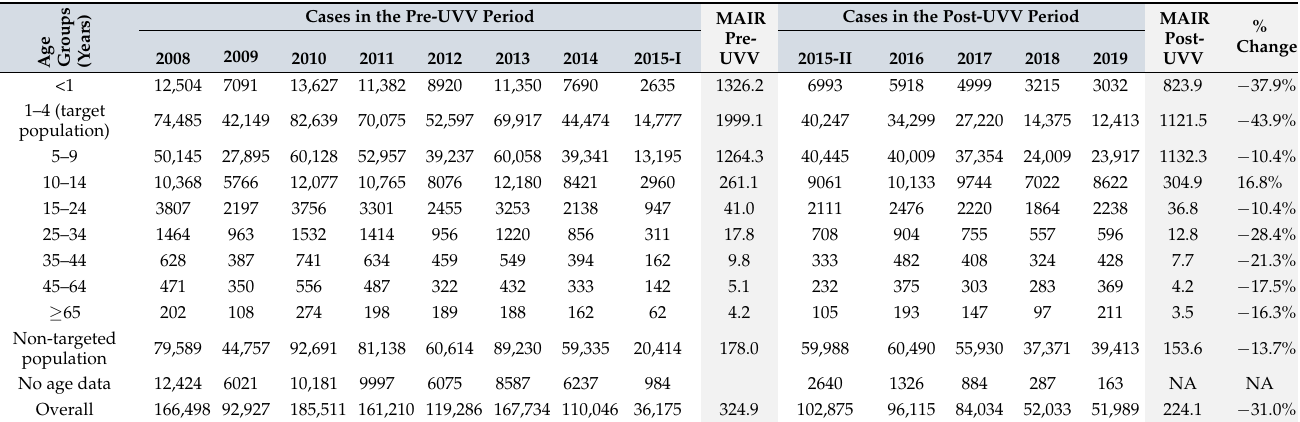
Table 1. Comparative analysis of varicella cases and incidence pre- and post-UVV introduction, by age